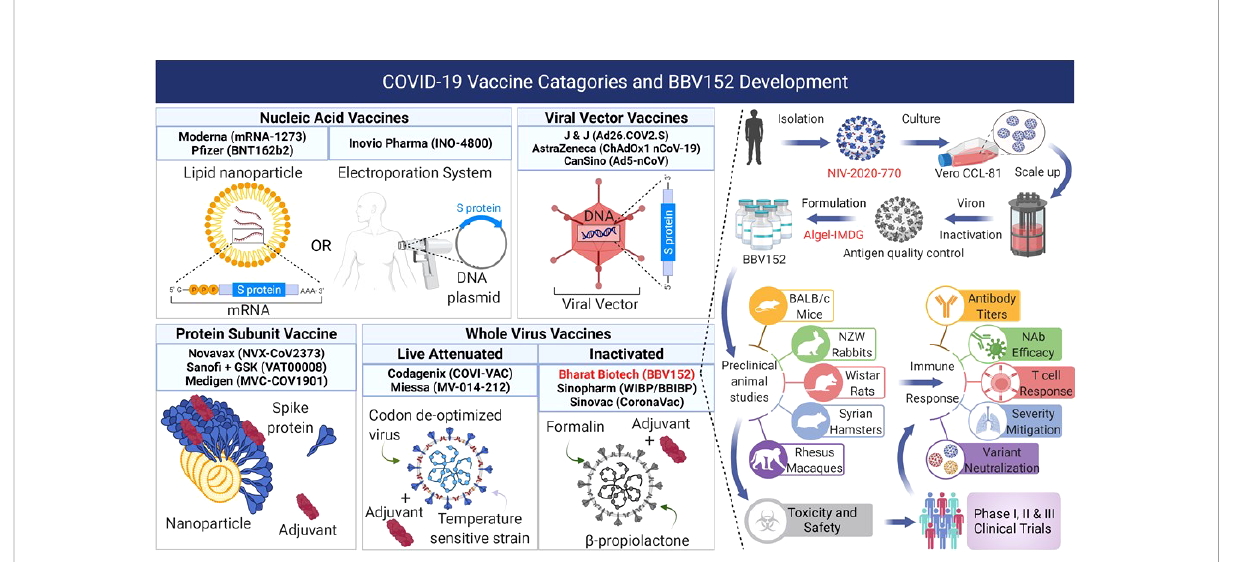
FIGURE 1 COVID-19 vaccines in development, clinical trials, or approved use, fall into four main categories: 1) Nucleic acid vaccines that use RNA or DNA to provide host cells with the instructions to make the viral antigens. 2) Viral vector vaccines use replicating or non-replicating, non-pathogenic viruses to deliver the genetic instructions to the host cells to produce antigens. 3) Protein subunit vaccines use fragments of antigens as proteins or assembled virus-like nanoparticles delivered directly into the host. 4) Whole virus vaccines use the complete virus that is either attenuated or completely inactivated. BBV152 is a whole virus inactivated vaccine produced from the NIV-2020-770 strain of SARS-CoV-2 strain by destroying the viral genetic material while leaving the antigens intact. The inactivated virus is formulated with the Algel-IMDG adjuvant (TLR7/8 agonist) and used for preclinical animal studies for safety and immunogenicity followed subsequently by Phase I, II, and III clinical trials to evaluate its safety and ef fi cacy in human participants. Figure created with